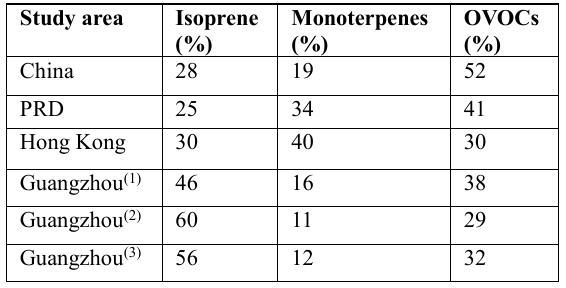
Table 3. Comparison with percentage of each chemical species